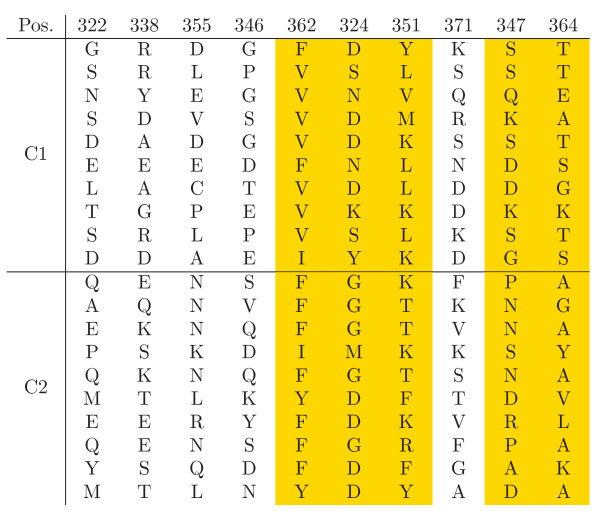
Evaluation of predicted functional residues for the SH3 data. Top ten ranked alignment positions on the SH3 data set. The experimentally verified ligand interacting sites are marked in yellow.